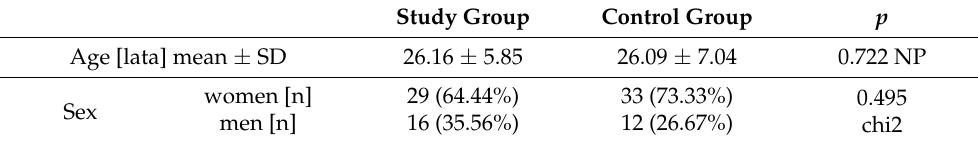
Table 1. Characteristics of the study group.